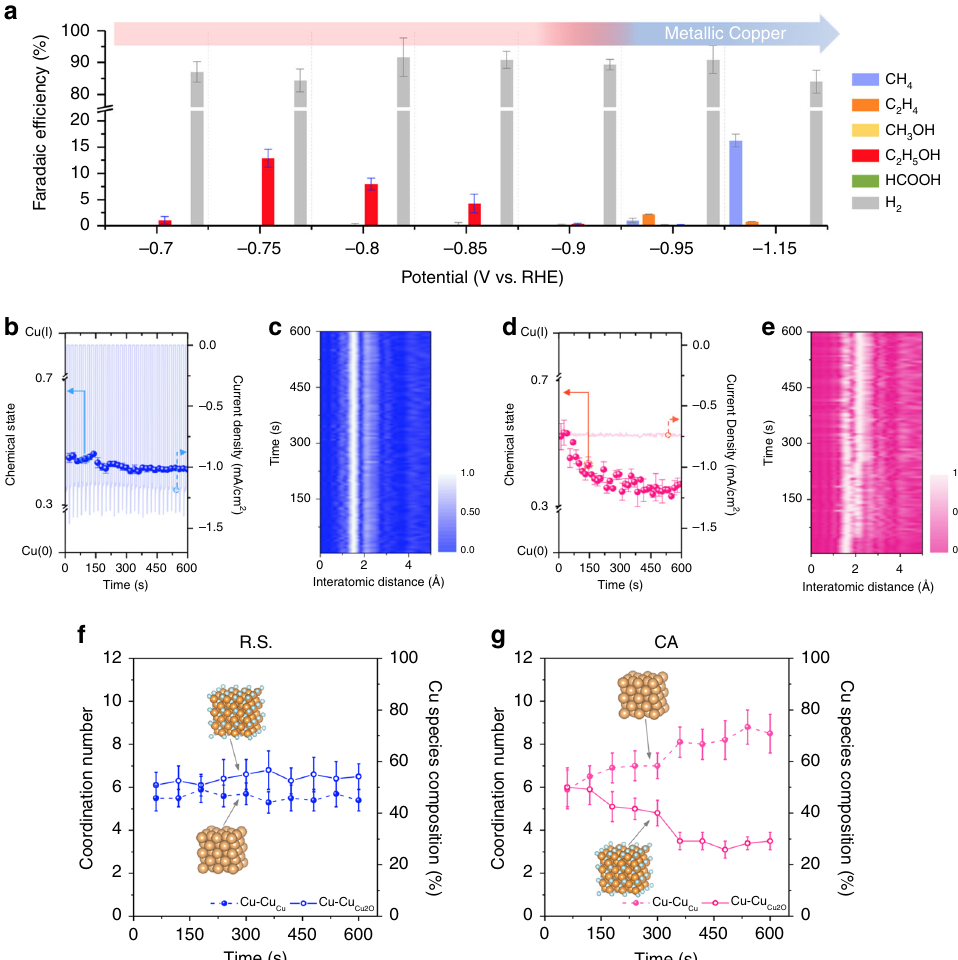
Fig. 2 Operando time-resolved XAS characterization. a Potential dependence of CO 2 RR product selectivity on the CuO x in 0.5 M CO 2 -saturated KHCO 3 under the employment of redox shuttle. The error bars represented standard deviations based on three individual measurements. b Time-resolved variations using Redox Shuttle (R.S.) of Cu species in CuO x and the corresponding electrochemical responses during CO 2 RR at − 0.75 V and c the corresponding time-resolved EXAFS spectra without phase-correction of CuO x under CO 2 RR. d Time-resolved variations using chronoamperometry (CA) of Cu species in CuO x and the corresponding electrochemical responses during CO 2 RR at − 0.75 V and e the corresponding time-resolved EXAFS spectra without phase-correction of CuO x under CO 2 RR. The spectra were depicted in a 2D contour plot with interatomic distance (Å) on x -axis and with time (sec) on y -axis, while normalized Fourier transform magnitude served as corresponding intensity. Quanti fi cation of time-resolved chemical composition information extracted from operando Quick Cu XAS for CuO x under eCO 2 RR using redox shuttle ( f ) and conventional chronoamperometry ( g ). Each error bar indicated an estimated standard deviation based on the curve fi tting of EXAFS spectra. Both cathodic potentials were − 0.75 V and electrolyte was 0.5 M CO 2 -saturated KHCO 3